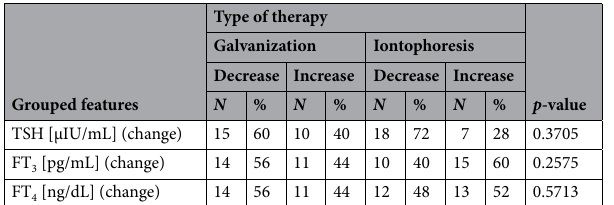
Table 3. The number and percentage of people for whom the given parameter increased and decreased from T1 to T2. p -test probability value calculated using the chi-square test of independence.